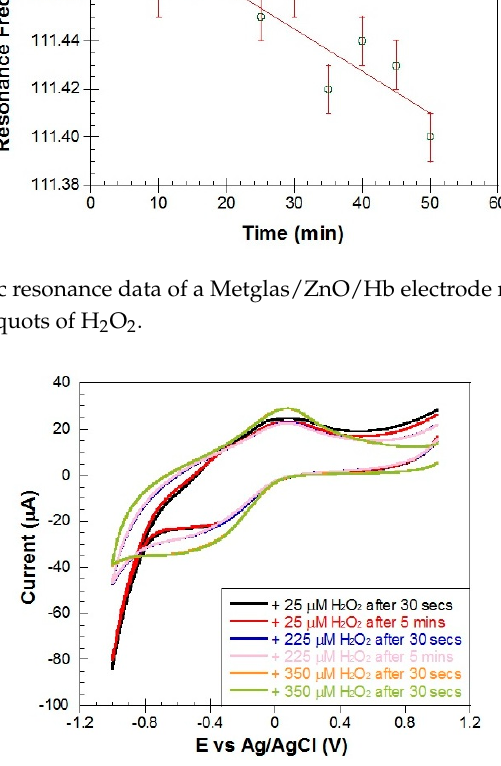
Figure 15. CVs of a Metglas/ZnO/Hb electrode at a scan rate of 0.1 V/s after the addition of three different concentrations of H 2 O 2 measured after 30 s and 5 min after each addition.